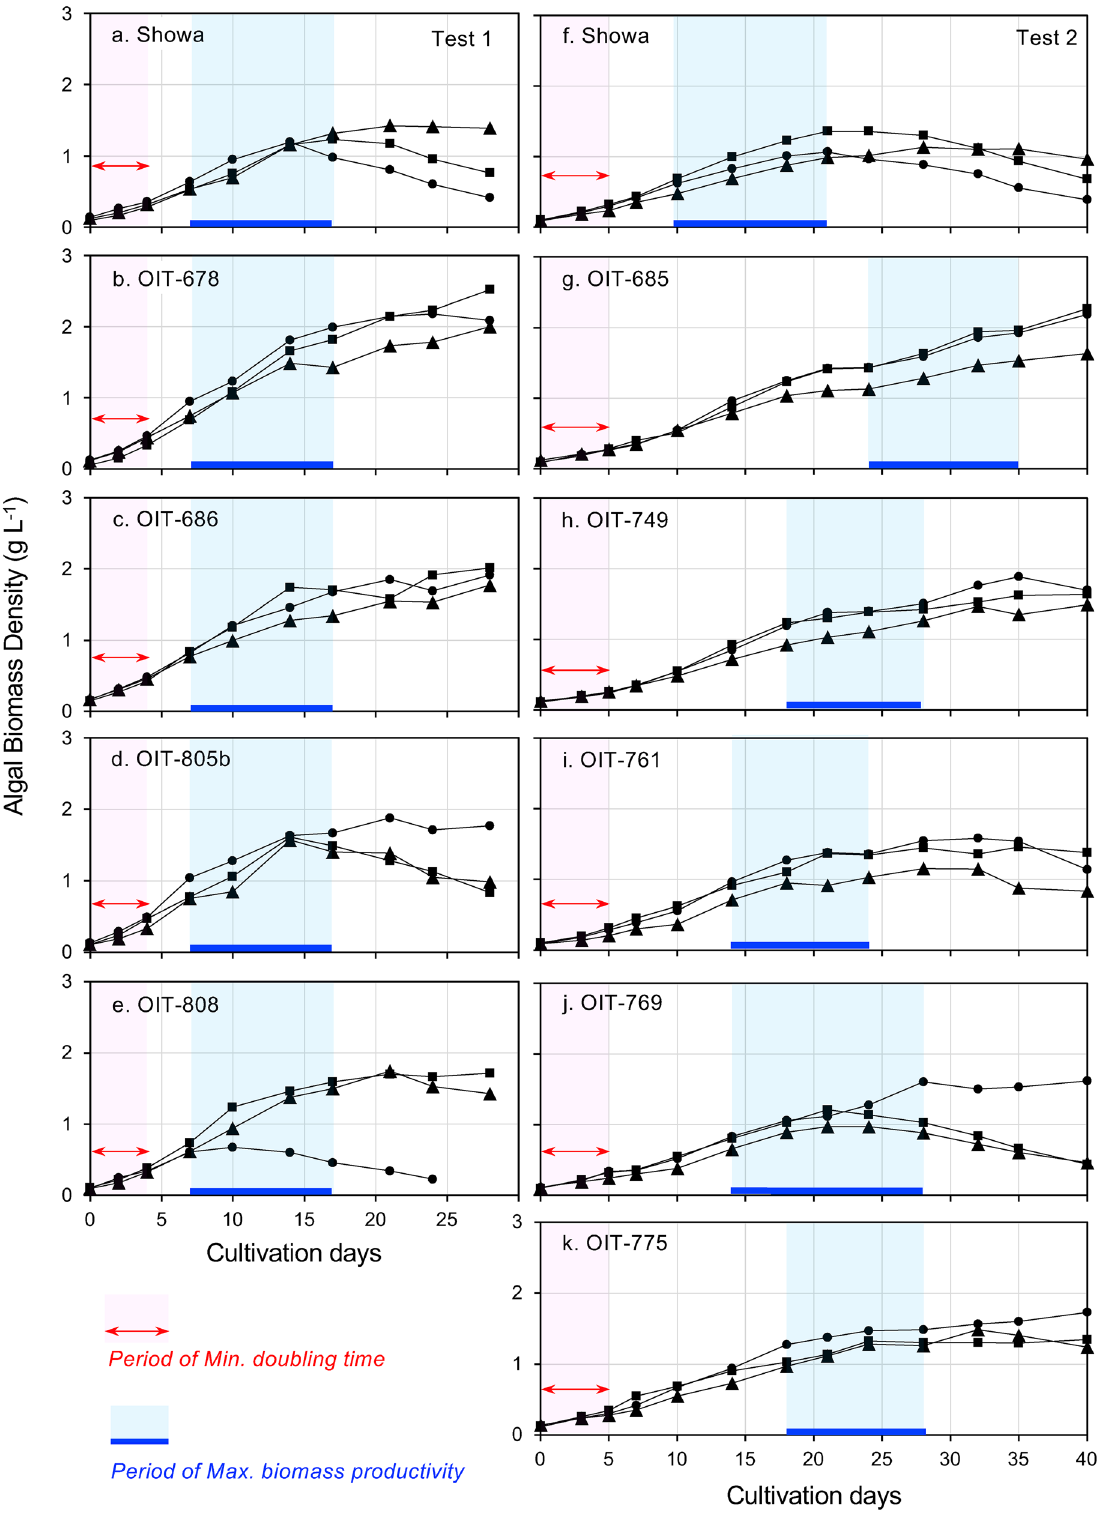
Figure 3. Biomass growth curves of fast-growing wild strains of Botrycoccus braunii in a fed-batch culture system. Every 2–3 days, 100 mL (20%) of culture was sampled to estimate algal biomass density, and the same amount of new medium was added. ( a )–( e ): Test 1 for 4 wild strains with a standard strain, Showa. ( f )–( k ): Test 2 for five wild strains with Showa. There were 3 repetitions ( ■ , ▲ , ) of culture bottles for each strain. The arrow indicates the period of minimum doubling time, the horizontal bar indicates the period of maximum ● biomass